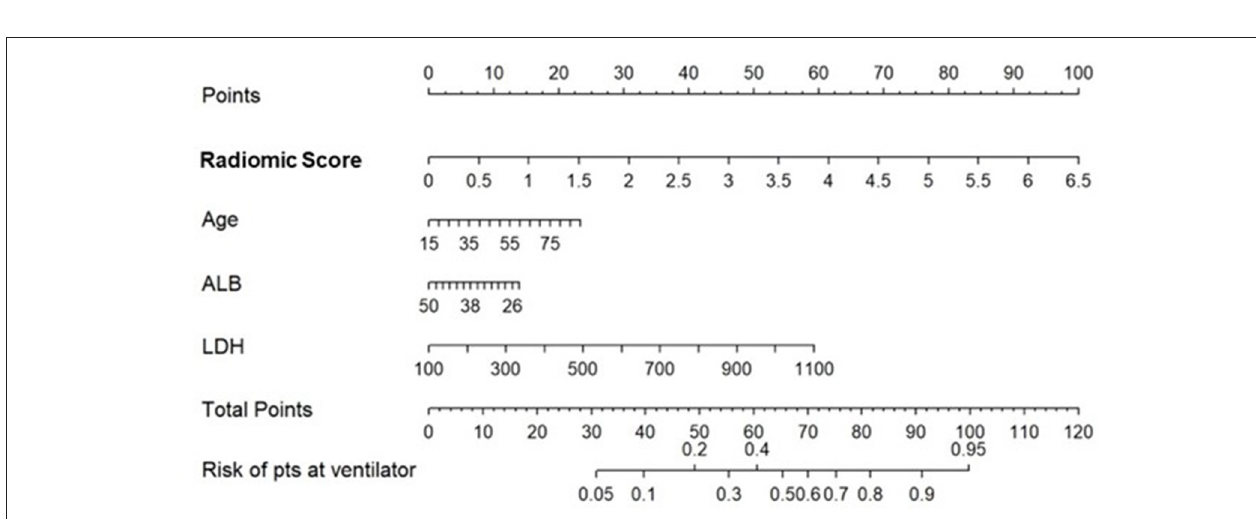
FIGURE 5 | Constructed nomogram, M RCM , which included radiomic score, age, albumin (ALB), and lactate dehydrogenase (LDH). The nomogram calculates the probability of the patient being on the ventilator.